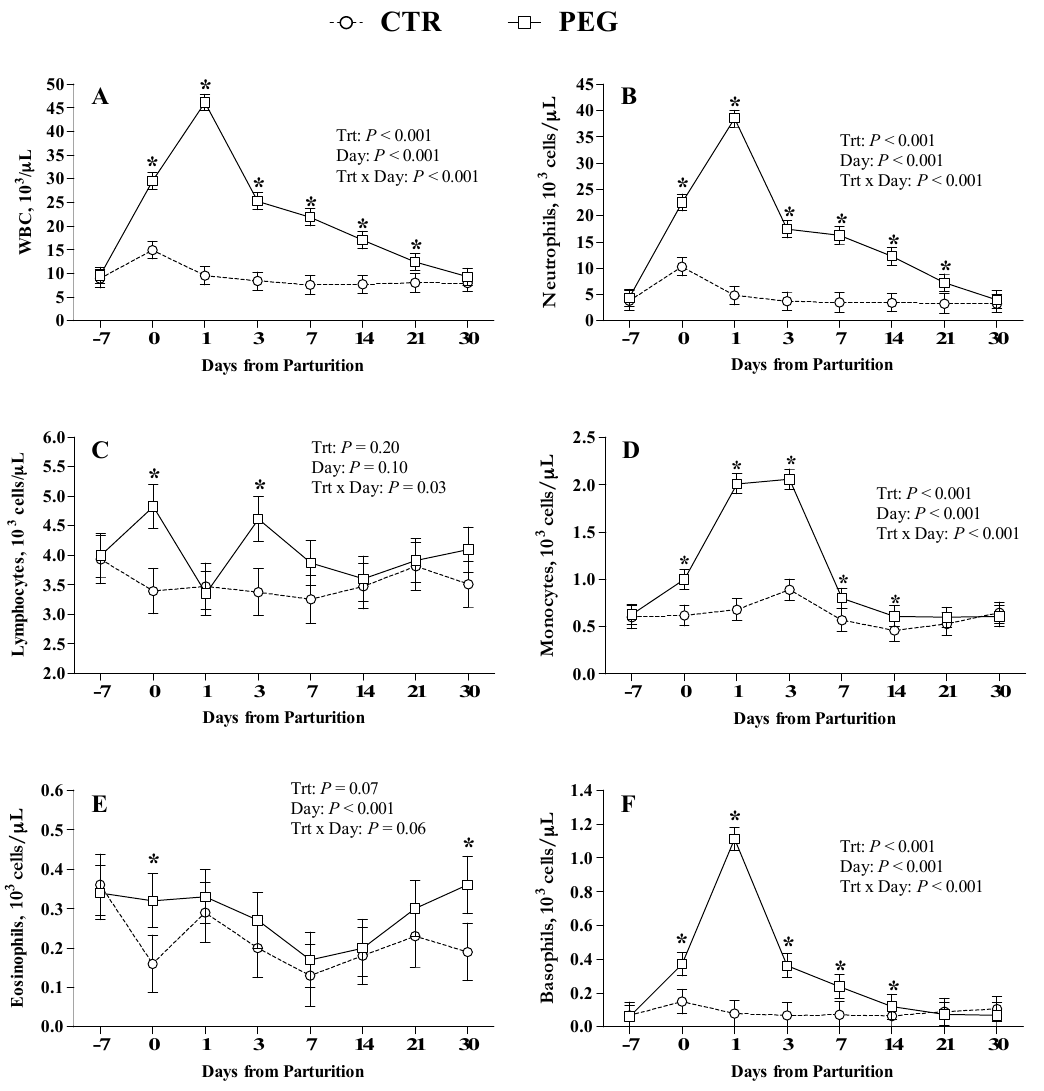
Figure 1. E ff ect of Pegbovigrastim on total white blood cell (WBC) count and di ff erential WBC count. Least-squares means ± standard error of ( A ) circulating total whole blood leukocytes (WBC × 10 3 / µ L), ( B ) neutrophils ( × 10 3 / µ L), ( C ) lymphocytes ( × 10 3 / µ L), ( D ) monocytes ( × 10 3 / µ L), ( E ) basophils ( × 10 3 / µ L) and ( F ) eosinophils count ( × 10 3 / µ L) during the transition period of Simmental cows treated either with 2 subcutaneous injections of pegbovigrastim (PEG) or saline solution (CTR) at − 7 days relative to calving and within 6 h after calving. Asterisks (*) indicate di ff erences at p < 0.05.